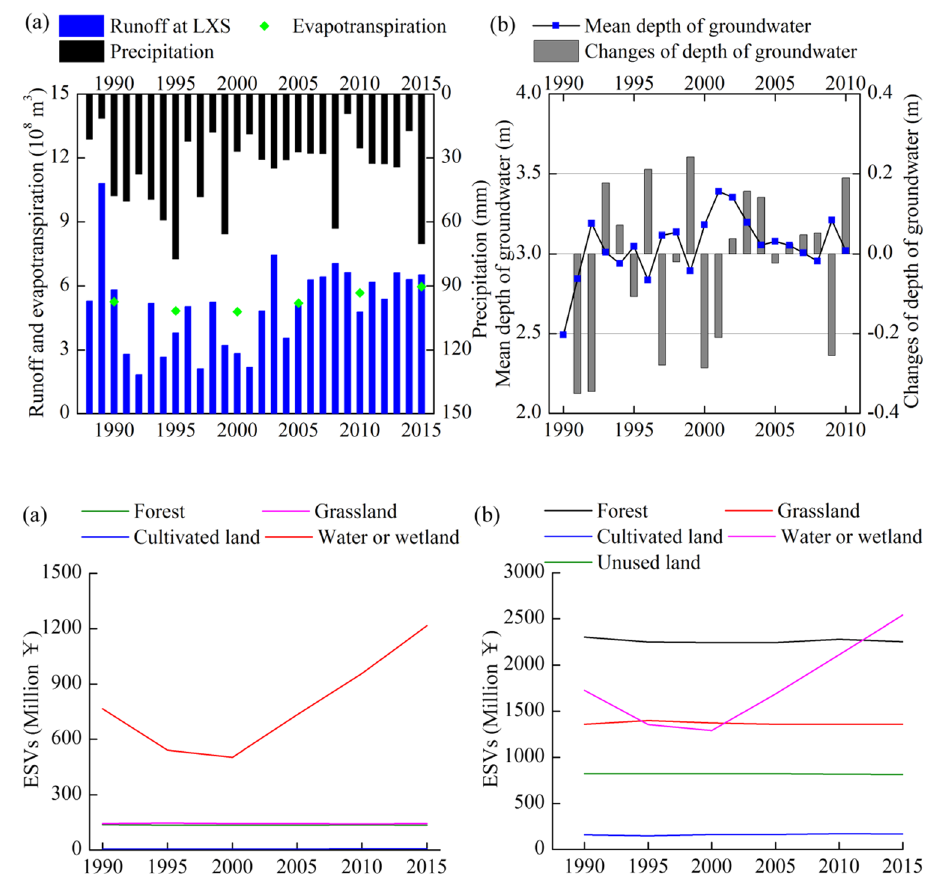
Fig. 5 The ESVs estimated using the modified value per unit area method ( a ) and the value equivalent factor per unit area method ( b